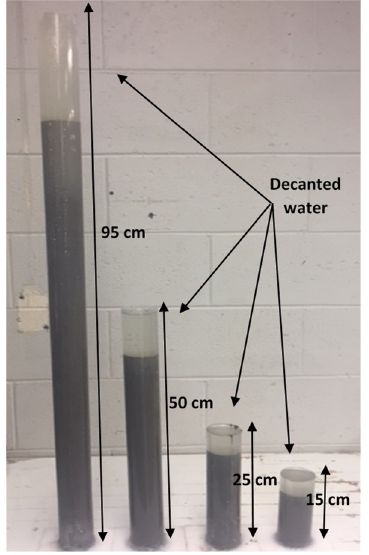
Figure 4. Illustration of cemented hydraulic fill placed in different columns after complete settlement.